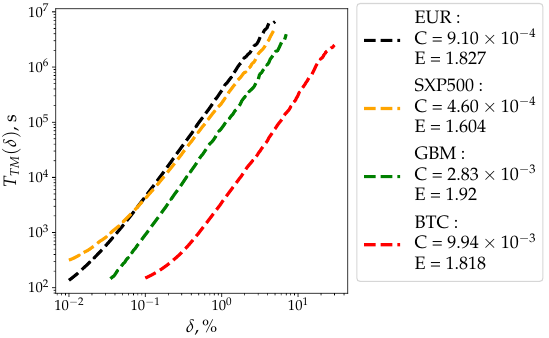
Figure 4. Time of total-move scaling laws computed for BTC/USD, EUR/USD, SPX500, and Geometrical Brownian Motion (GBM). GBM’s parameters are S 0 = 1.3367, µ = 0, σ = 20%, T = 1 year, and 10 million ticks in total. Scaling parameters C and E correspond to the coefficients of Equation